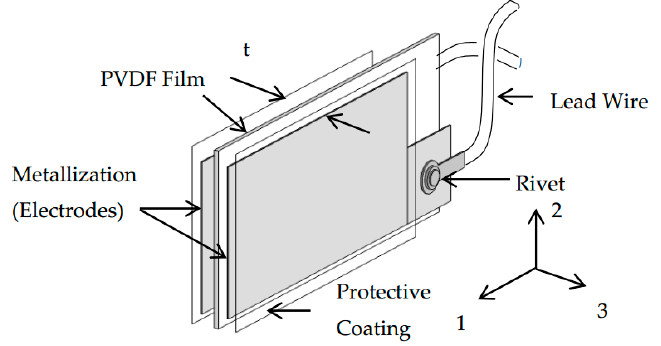
Figure 1. Schematic configuration of PVDF sensor.